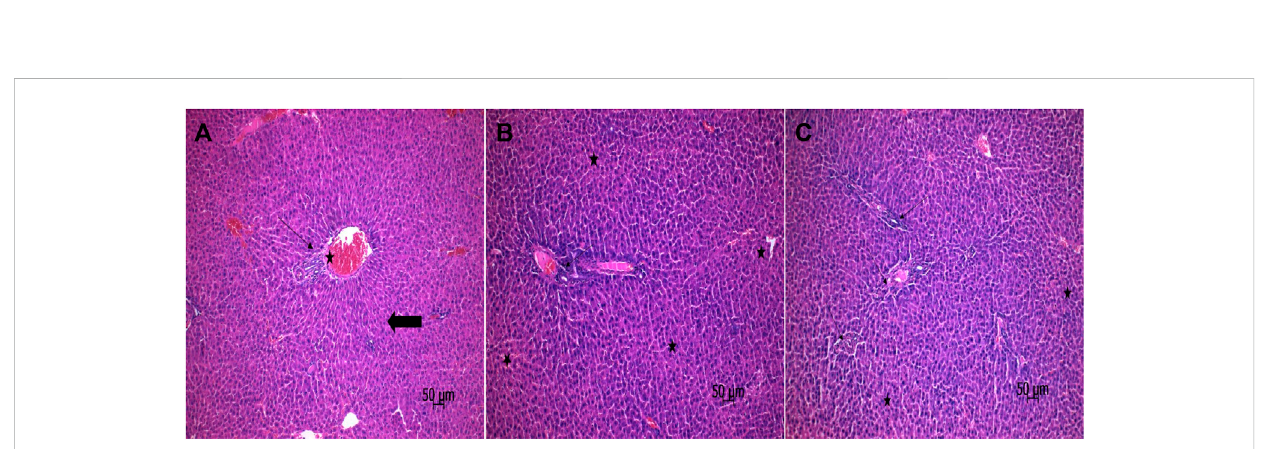
FIGURE 5 (A – C)(A) SectionsofthenormallivertissueoftheHG.Normalportalarea(star),parenchyma(thickarrow)andlimiting plate(thinarrow)appearance in liver tissue (H&E) (B) Histopathological image of ACR group. Diffuse degenerative changes and necrosis (star) in hepatocytes and moderate in fl ammation(thinarrow)intheportalareaofthelivertissue.(H&E) (C) Histopathological imageoftheCACR group. Mildfocaldegenerative changes and necrosis (star) in hepatocytes, and mild in fl ammation (thin arrow) in portal areas